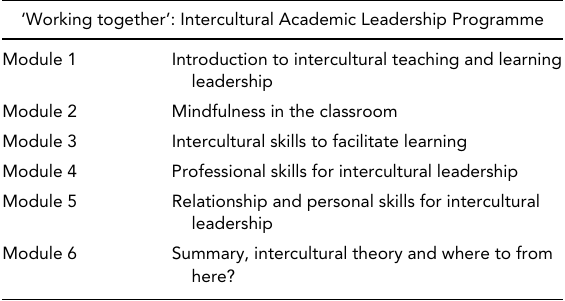
WorkingTogetherProgramme Modules ∗